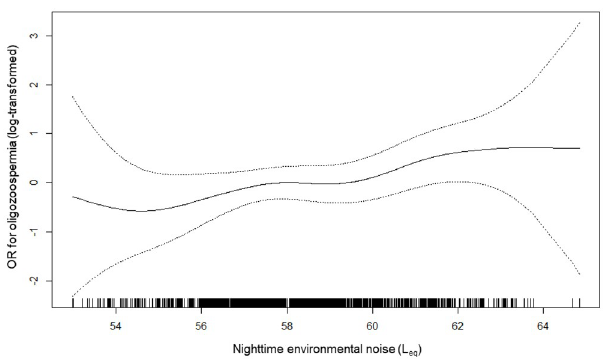
Fig 1. Relationship between nighttime environmental noise and odds ratio of oligozoospermia (log-transformed). Solid and dotted lines indicate smoothing spline lines and their 95% confidence intervals.